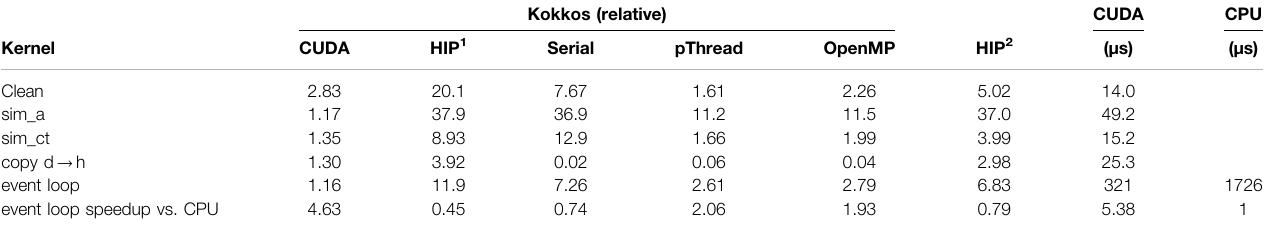
TABLE 4 | Relative kernel average execution times with various Kokkos backends, as a factor of the pure CUDA implementation execution time. HIP 1 is for Kokkos with the HIP backend, whereas HIP 2 is a direct port from CUDA to HIP. The last two columns show the absolute kernel runtimes for the original CUDA code, and for the native CPU implementation, averaged over 10,000 events. The last row shows the relative speedup of the event loop versus the native CPU implementation.